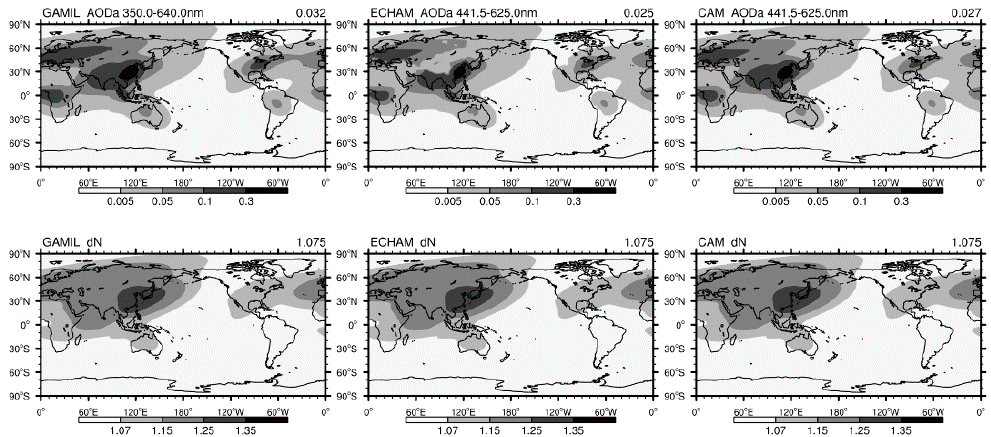
Figure 1. Anthropogenic aerosol (the year of 2000) optical depth (AODa, unitless, upper) and Figure1. Anthropogenicaerosol(theyearof2000)opticaldepth(AODa, unitless, upper)andnormalized normalized change in drop number (dN unitless, lower) with the GAMIL (left), ECHAM (middle), change in drop number (dN unitless, lower) with the GAMIL ( left ), ECHAM ( middle ), and CAM and CAM (right) models. Global mean values are shown in the upper right corners. ( right ) models. Global mean values are shown in the upper right